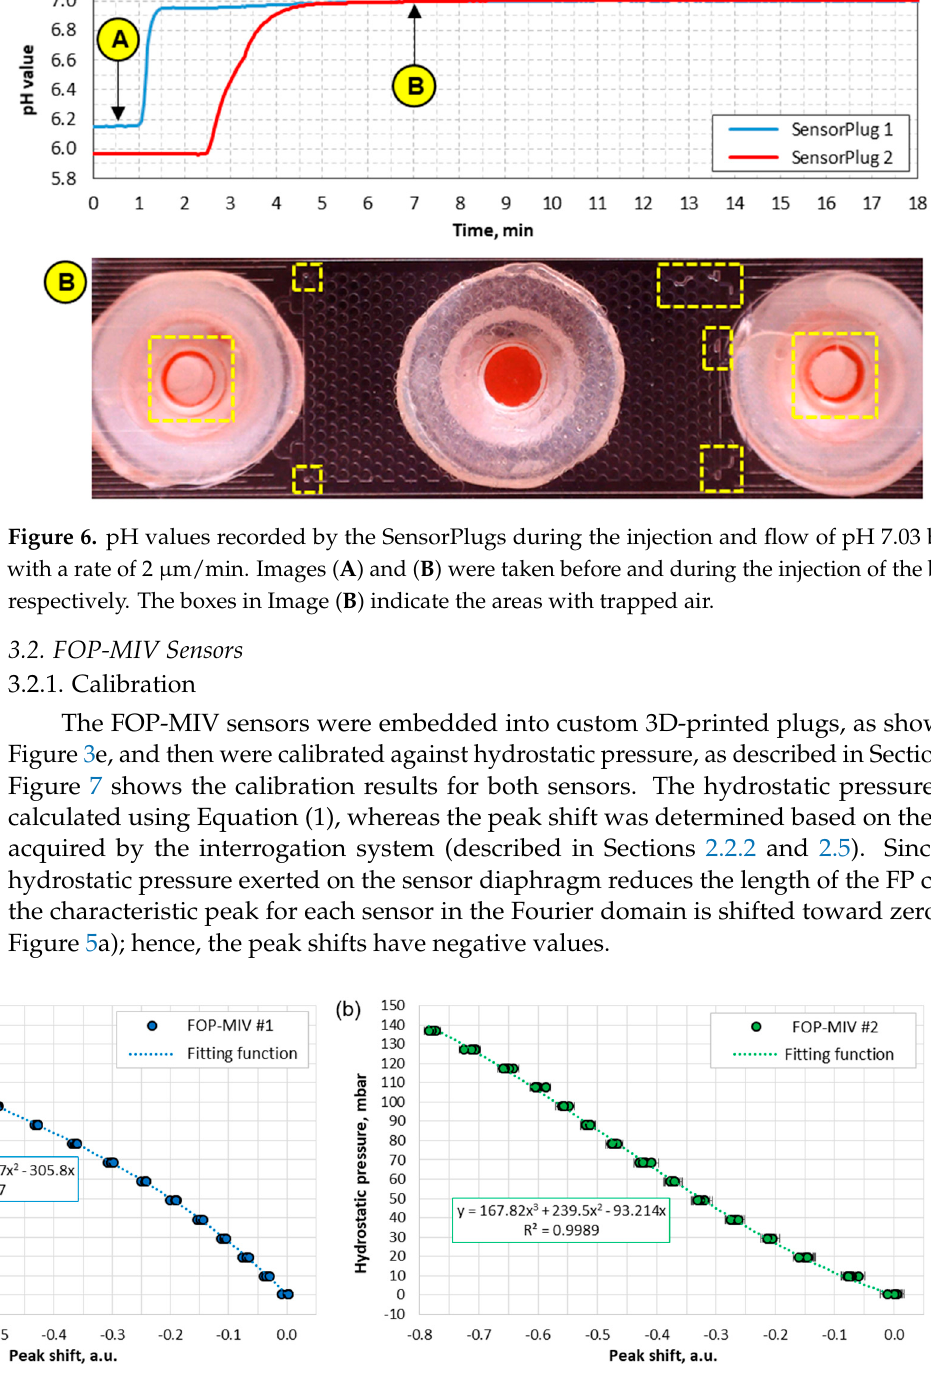
Figure 7. Calibration results and the 3 rd order polynomial fits for: ( a ) FOP-MIV #1 and ( b ) FOP-MIV #2.